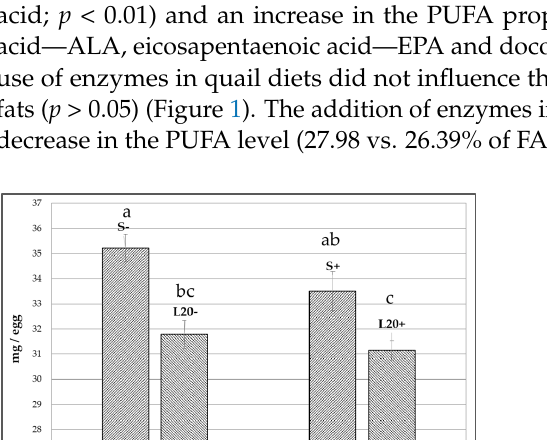
Table 9. Influence of enzymes addition in lupine-based diets on the carotenoids content (µg/g yolk) and the color of the yolk.